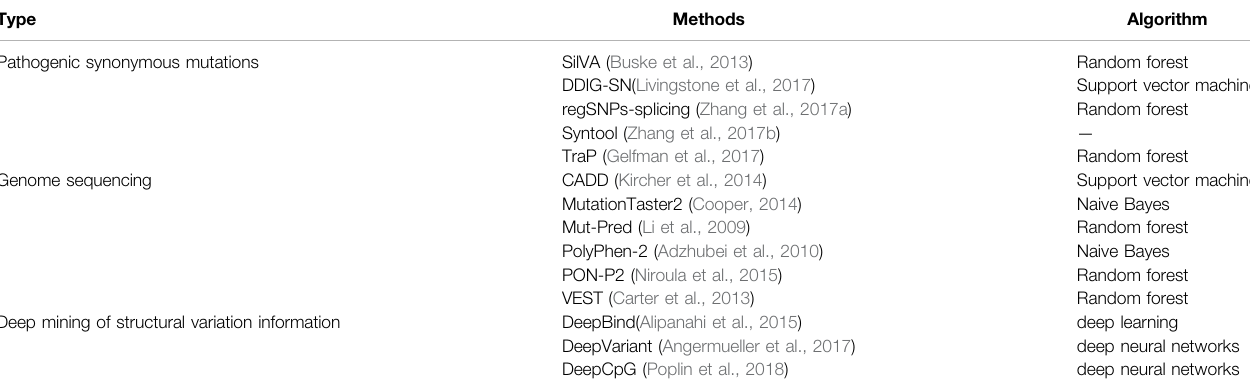
TABLE 1 | Summary of genomic variation prediction